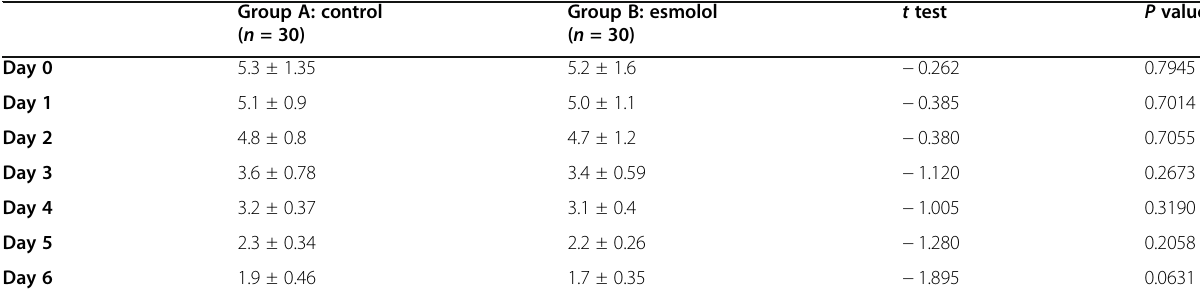
Table 8 Comparison between both groups according to serum lactate Group A: control ( n = 30)